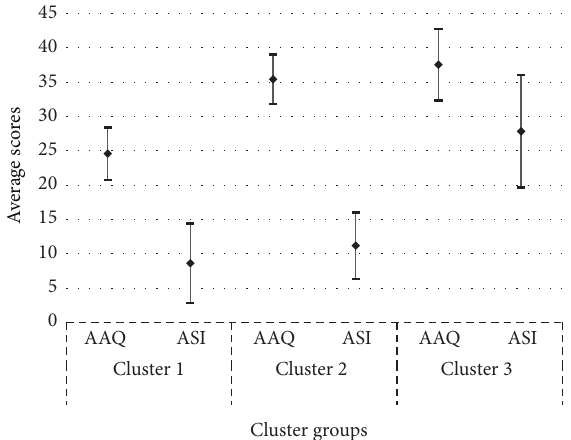
Figure 1: Two-step cluster subgroups based on anxiety sensitivity and experiential